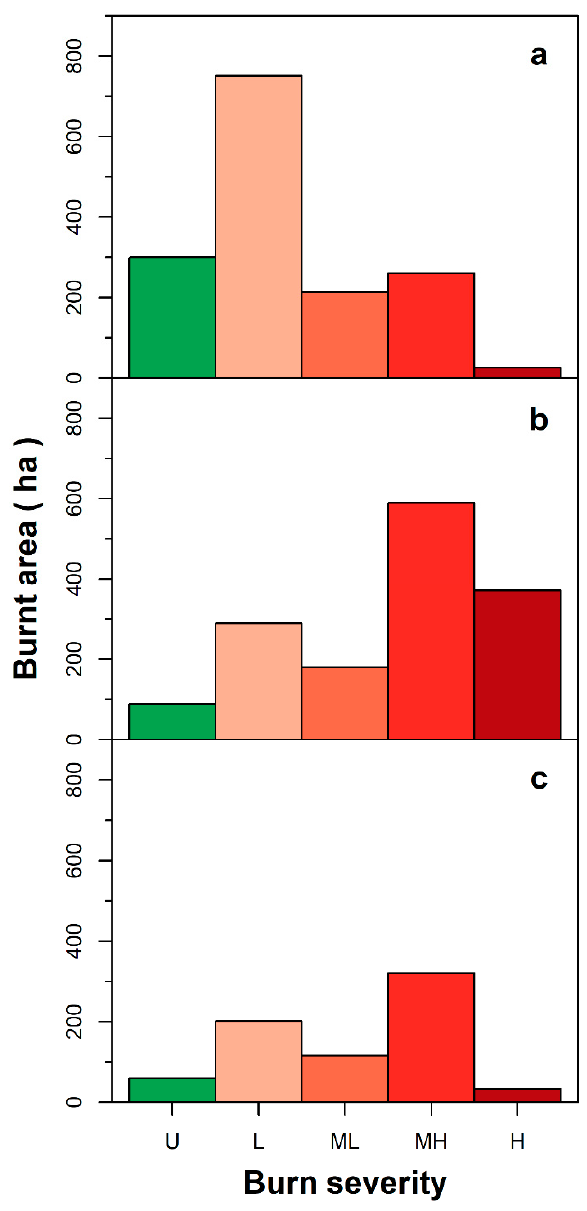
Figure 5. Area (ha) burnt by wildfires in summer 2017 in the Vesuvius National Park classified according to burn severity classes. Panels ( a ), ( b ), and ( c ) represent broadleaved species, Mediterranean conifers, and shrubland, respectively. See caption of Figure 2 and Table S1 for the burn severity class codes U, L, ML, MH, and H.